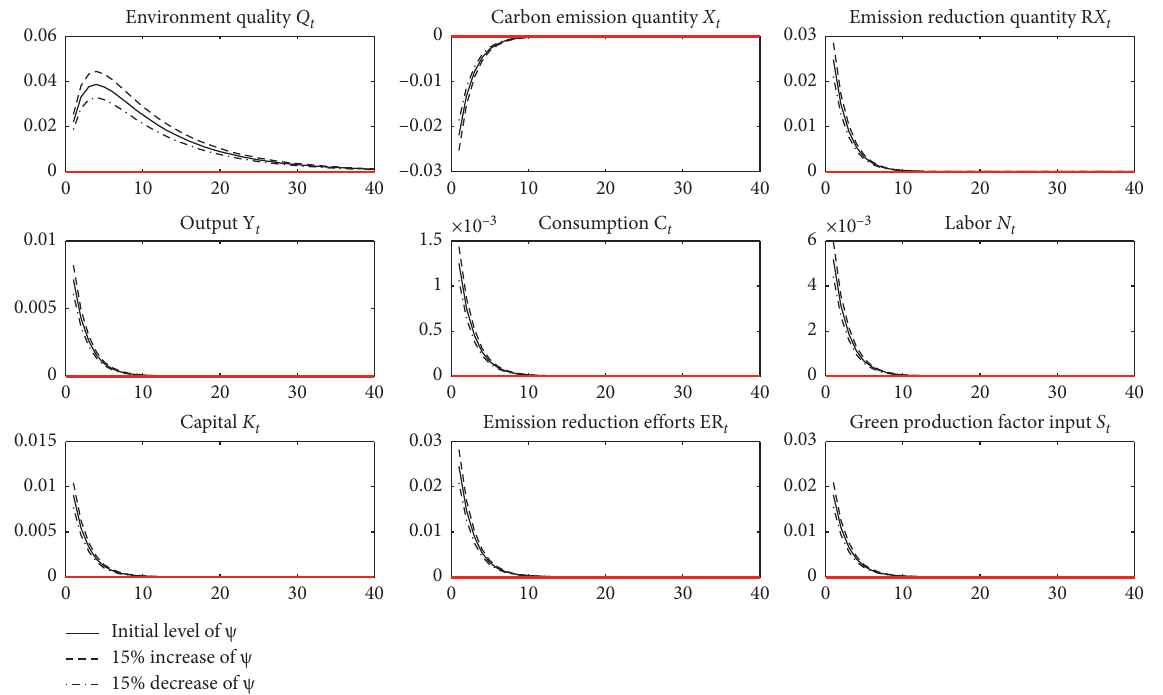
Figure 6: Sensitivity analysis on carbon emission reduction subsidy